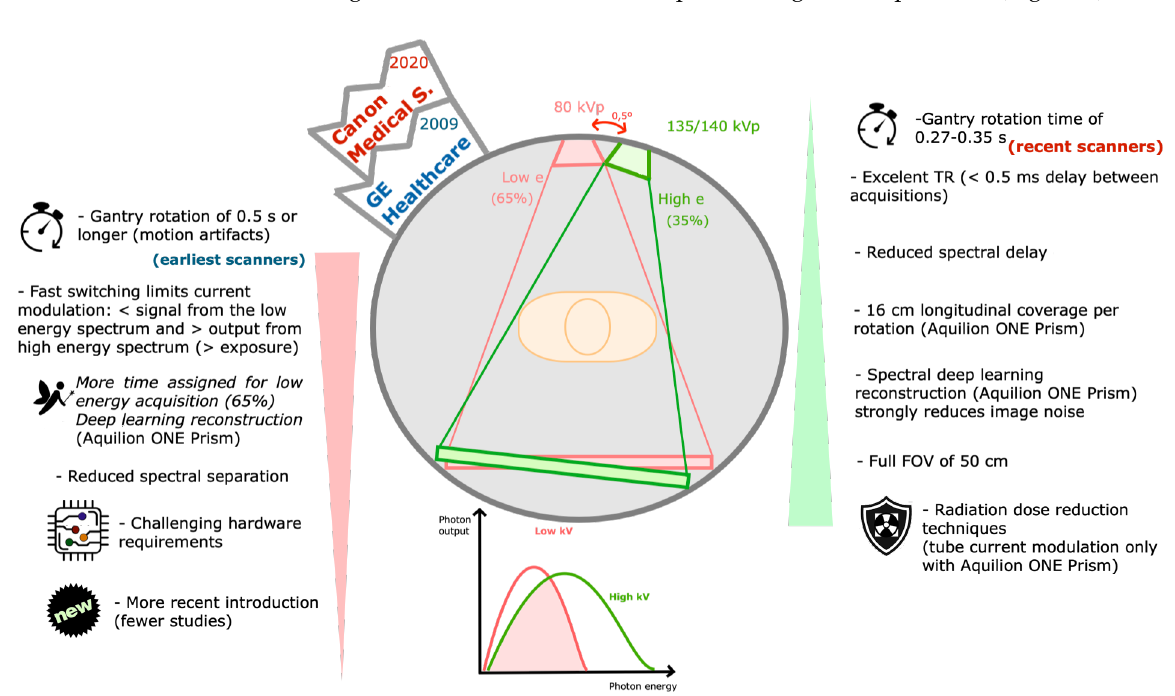
Figure 6. Single-source DECT with fast kVp switching of tube potential. Schematic representation of a fast kVp switching DECT scanner and its drawbacks (listed on the left) and strengths (listed on the right). These scanners (commercialized by GE Healthcare and Canon Medical Systems) are composed of a specialized generator capable of very fast switching between low- and high-energy spectra projections, which are collected separately by a specialized detector capable of fast sampling. Alternating acquisitions at 80 and 135 or 140 kVp are obtained on each rotation, with a small offset (<0.5°). Aquilion ONE Prism (Canon) offers 16 cm of longitudinal coverage and spectral deep learning reconstruction. e—energy, FOV—field of view, kVp—peak kilovoltage, s—seconds, TR—time resolution.